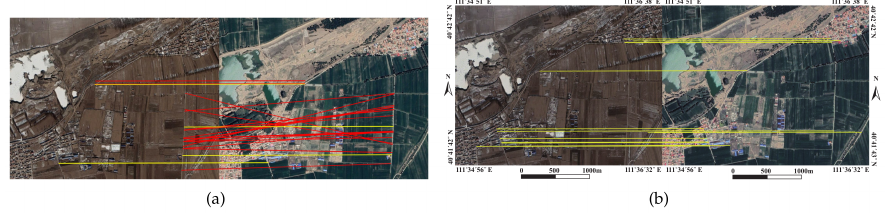
Figure 12. Matching results of image pair 4. ( a ) LJL; ( b ) Proposed.